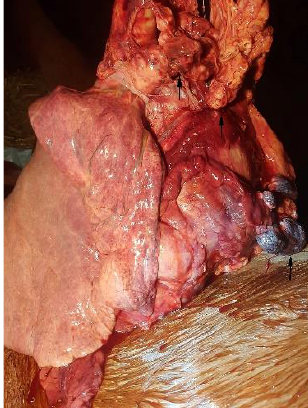
Figure 4. Lung: neoplastic nodules (arrows) arranged in clusters on the mediastinum.